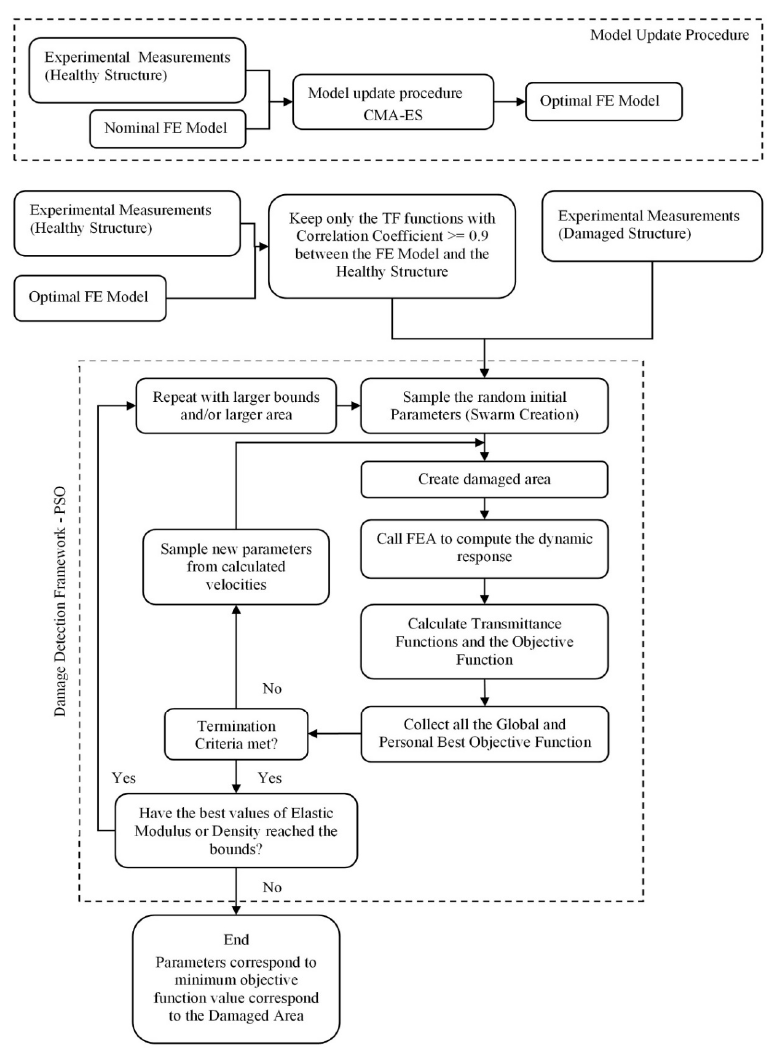
Figure 3. Flow-chart of the proposed damage-detection framework.